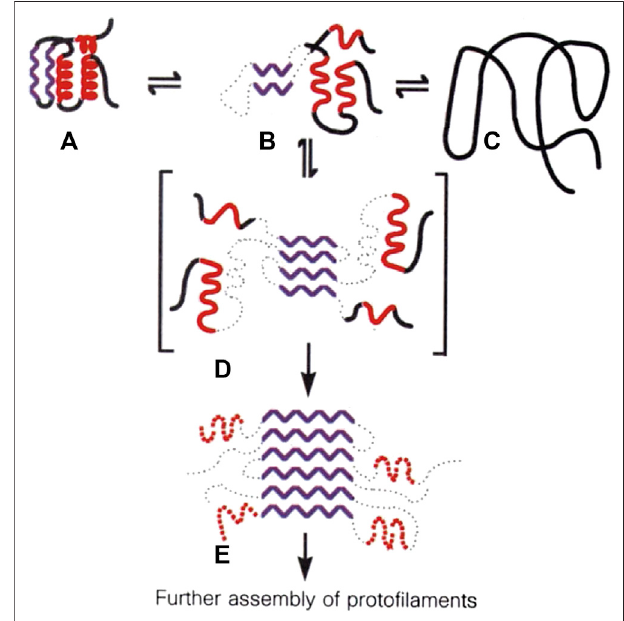
FIGURE 6 | Proposed mechanism for lysozyme amyloid fi bril formation. A molten globule form of the protein (B) , distinct from the native (A) and denatured (C) states, self-associates through the β -domain (D) to initiate fi bril formation and form the core structure of the fi bril (E) . The scheme was included in a previous manuscript published in Nature, 1997 (Booth et al.,